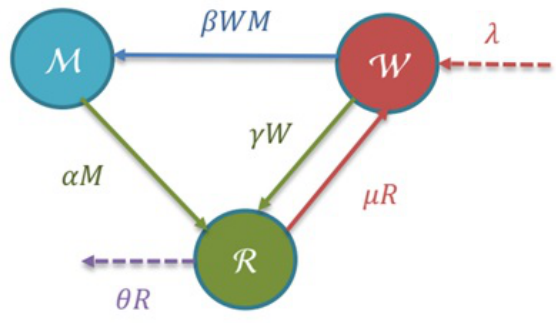
Figure 1. Flow diagram of the waste plastic